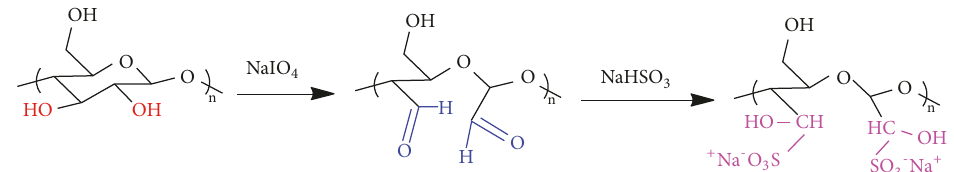
Figure 1: The chemical process for the introducing sulphurous acid groups onto cellulose through selectively oxidization and addition reaction.